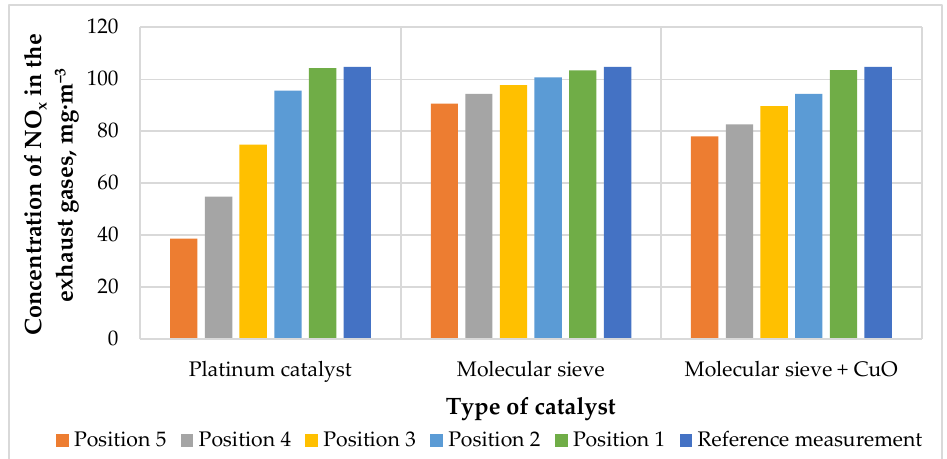
Figure 7. NO x concentration in exhaust gases depending on the type and location of the catalyst. Nitrogen oxides are an undesirable component of exhaust gases that significantly deteriorates the quality of the environment. During the combustion of landfill gas in a flare without the installed catalyst, the emission of these compounds was on average 105 mg · m − 3 . The use of catalysts in each configuration reduced the NO x concentration in the exhaust gases. The use of a platinum catalyst reduced the concentration of NO x in the range of 0.4–66 mg · m − 3 . After installing the catalytic bed in the form of a molecular sieve, the average NO x concentration in the exhaust gases decreased by an average of 1–14 mg · m − 3 . The catalyst in the form of a molecular sieve with a layer of CuO reduced the concentration of NO x in the exhaust gases in the range of 1–27 mg · m − 3 .